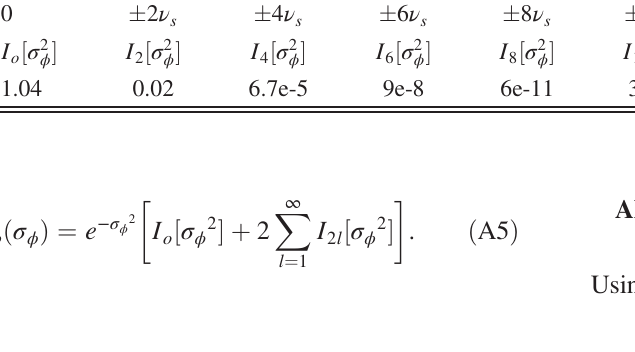
Table IV lists the weighting of the synchrotron sidebands harmonics in the resulting growth rate, for the nominal HiLumi LHC rms bunch length of 0.6325 rads. The contribution of the higher harmonics is negligible.